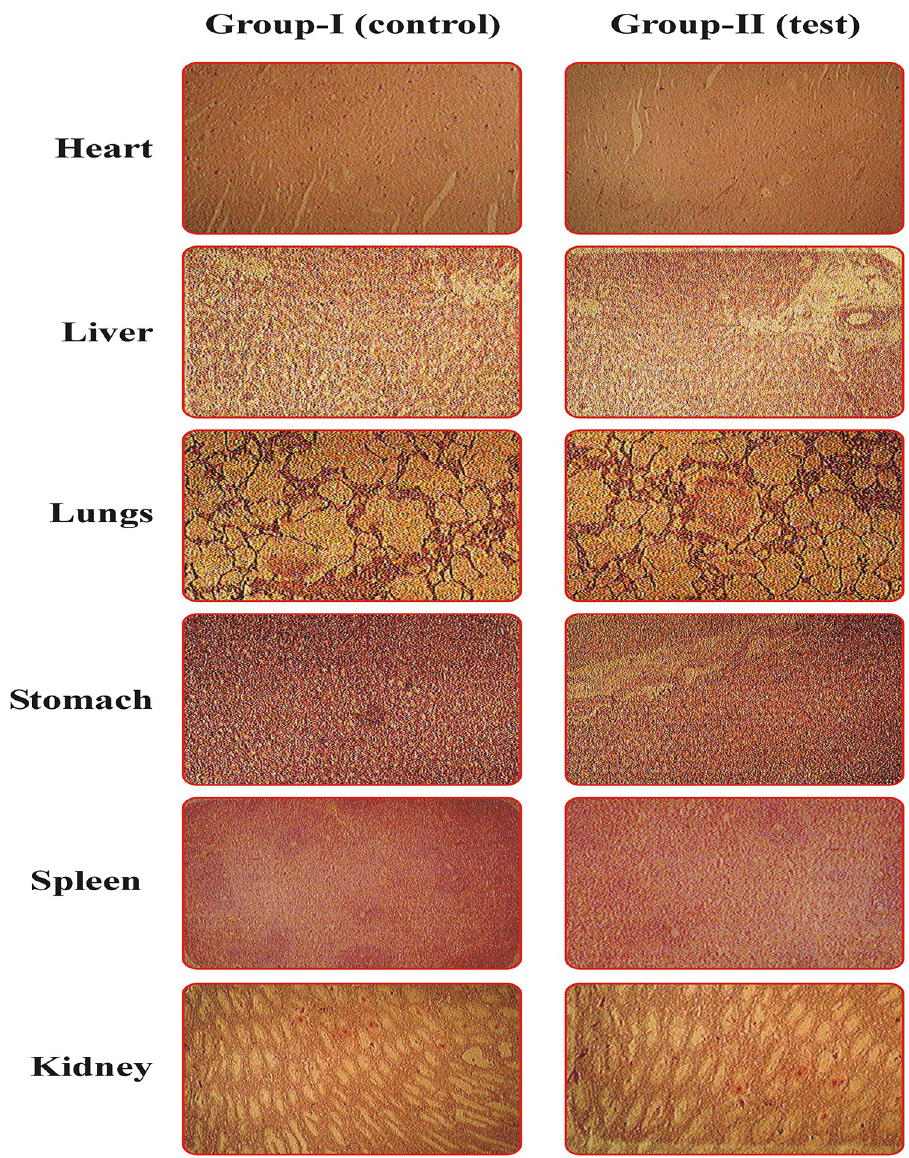
Fig 10. Histopathological microscopic examinations of vital organs of rabbit of Group-I (control) and Group-II (test).